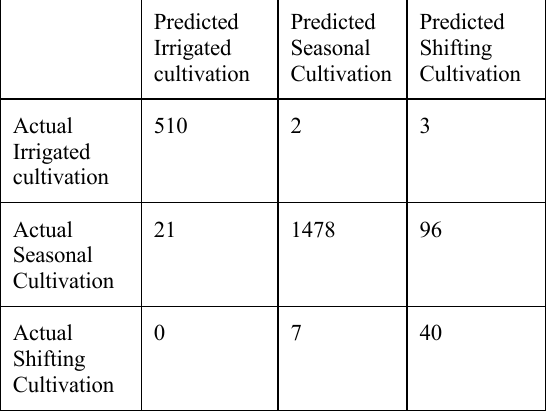
Table 2. Confusion matrix for 1988-2005 model run and validation based on 2005 land use map.